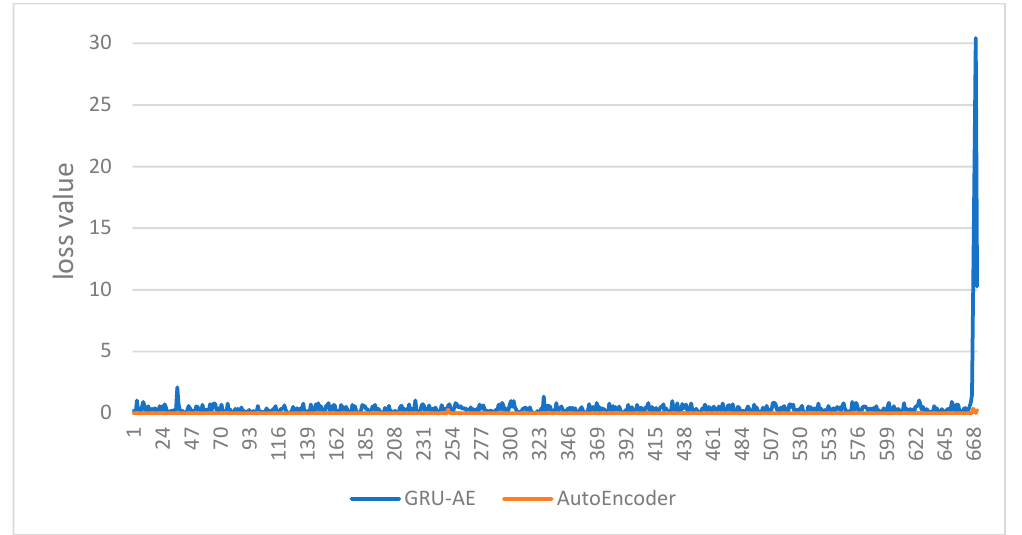
Figure 17. Comparison of the loss value changes of the two models in test set 2.